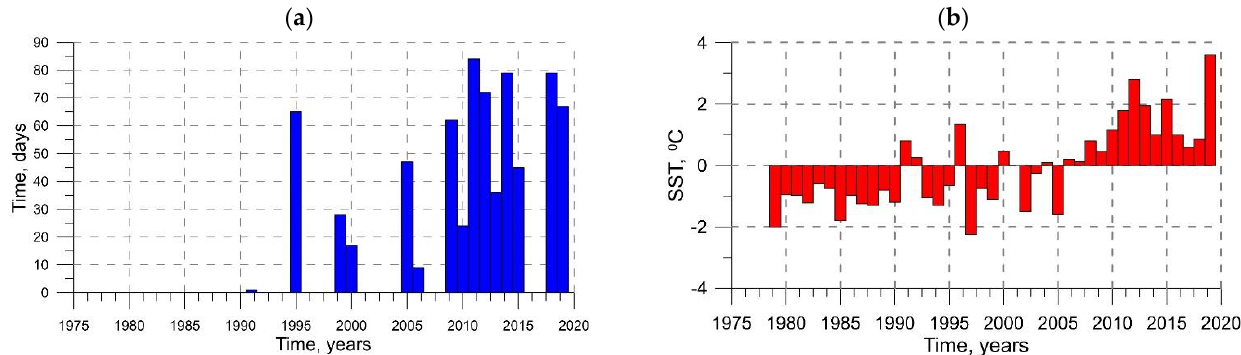
Figure 2. ( a ) Time series of the duration of the period of open water (ice concentration less than 15%) in the Laptev Sea ( a ), based on data from [5]; ( b ) SST anomaly in August–September on the Laptev Sea shelf, based on ERA5 atmospheric reanalysis